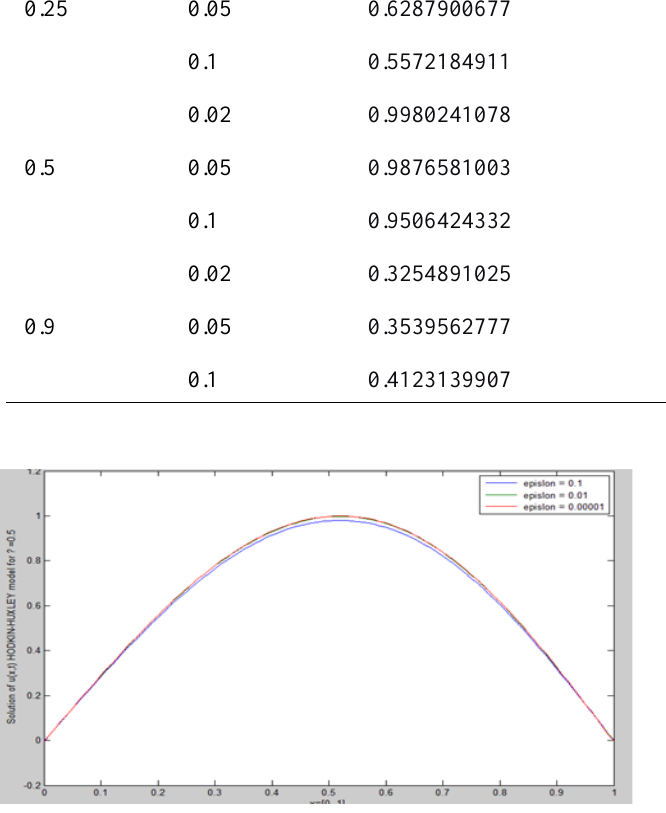
Fig. 4. Effect of Diffusion Co-efficient 𝜀 on the solution 𝑢(𝑥,